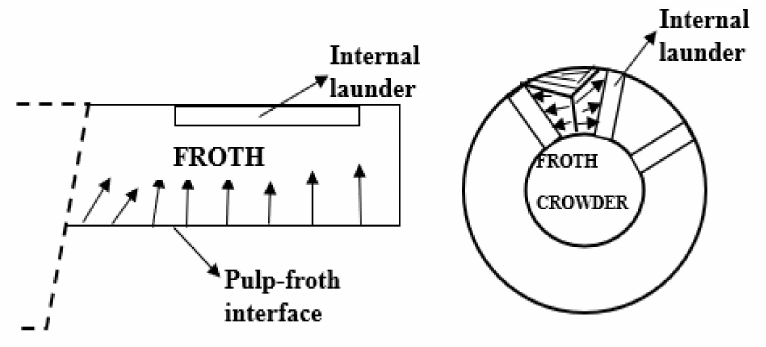
Figure 15. Cut and top view of the transport path in the froth of a large flotation cell